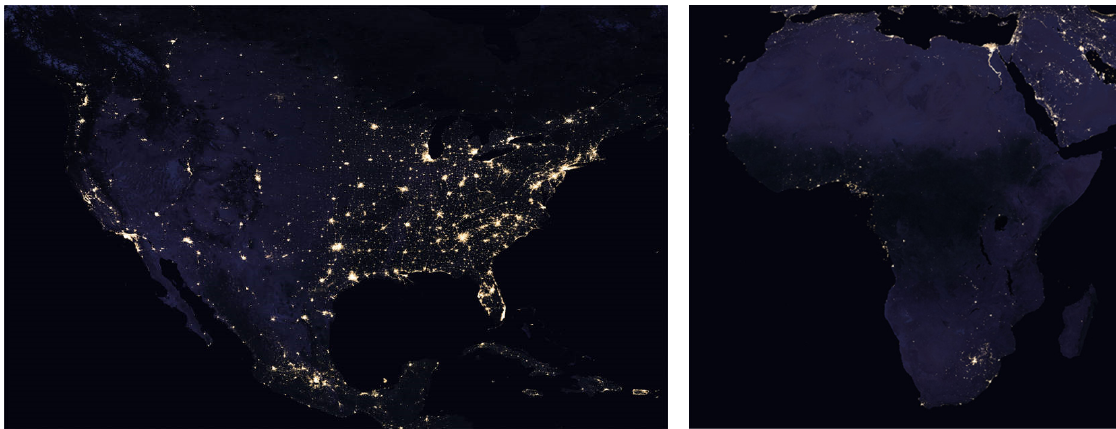
Figure 2. Earth at night, as seen in 2016: night lights in the USA vs. Africa. Source: NASA black marble Night-Time Lights (NTL) product suite (VNP46)